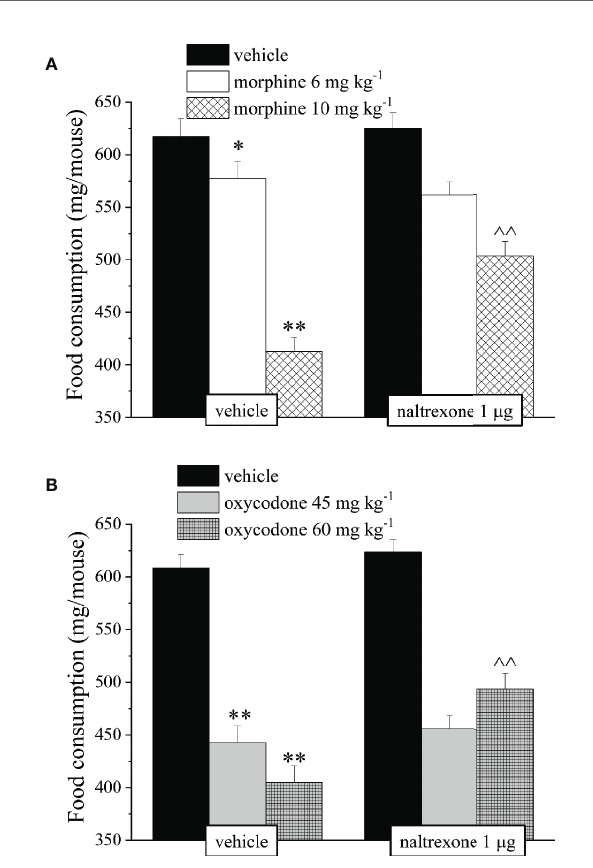
FIGURE 6 | Effect of intranasal administration of naltrexone on morphine and oxycodone induced food intake inhibition in the mouse. Food consumption was expressed as the weight consumed (mg/mouse) during 60 min after the injection of (A) morphine (6 – 10 mg kg − 1 ) or (B) oxycodone (45 – 60 mg kg − 1 ). Naltrexone 1 m g was intranasally administered 30 min before the intraperitoneal injection of the opioids. Control animals were treated with vehicles. Each value represents the mean of 10 mice per group, performed in two different experimental sets. *P < 0.05 and **P < 0.01 vs vehicle-treated animals; ^^P < 0.01 vs morphine or oxycodone-treated animals.